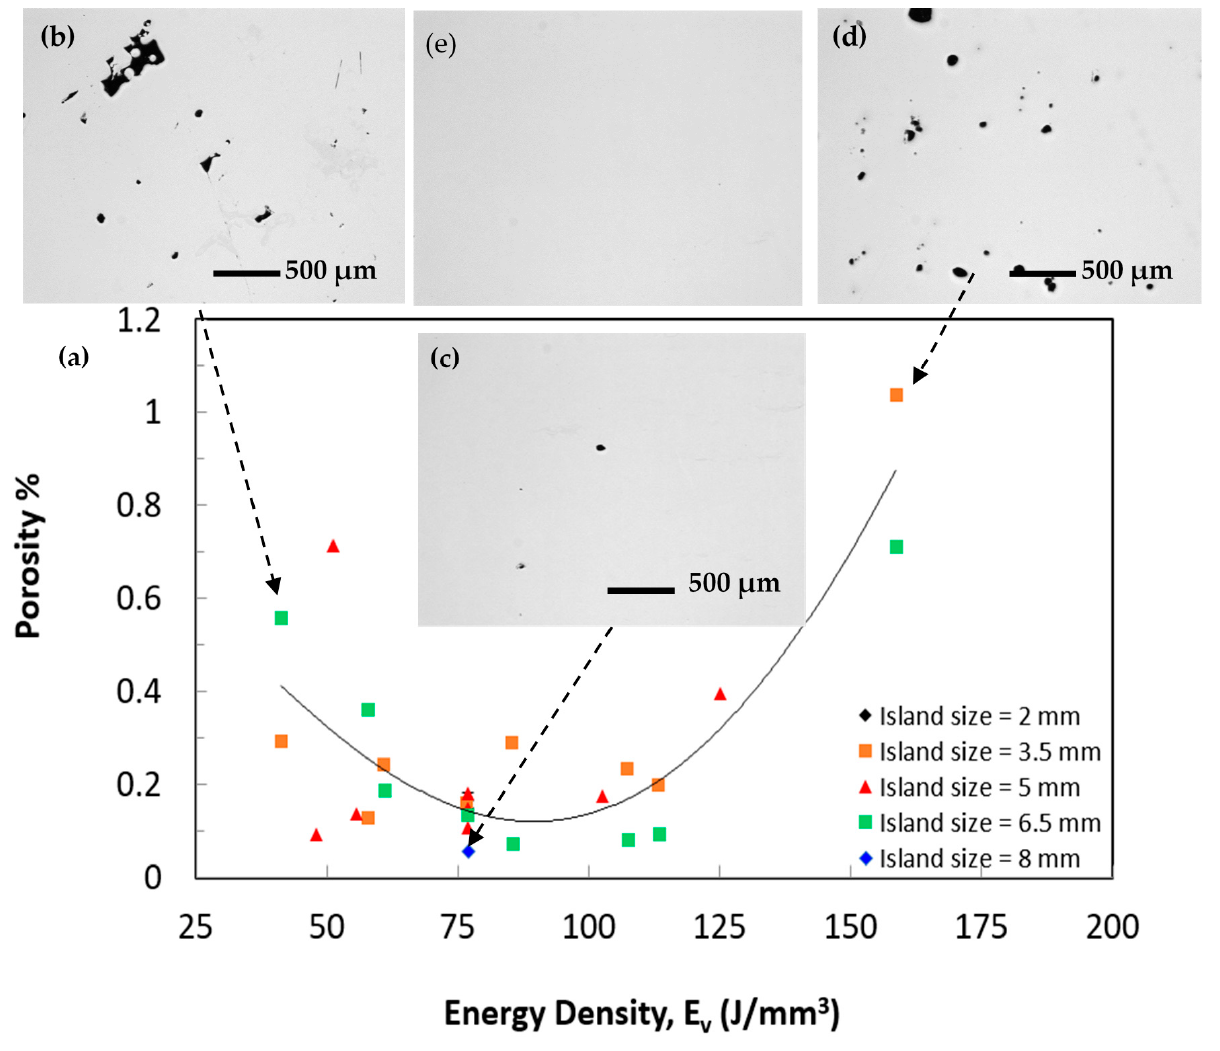
Figure 9. ( a ) Porosity level as a function of laser energy density ( b – e ) OM images of the samples fabricated using ( b ) Ev of 41 J/mm 3 , ( c ) Ev of 77 J/mm 3 , ( d ) Ev of 158 J/mm 3 , ( e ) HIPed post processing.